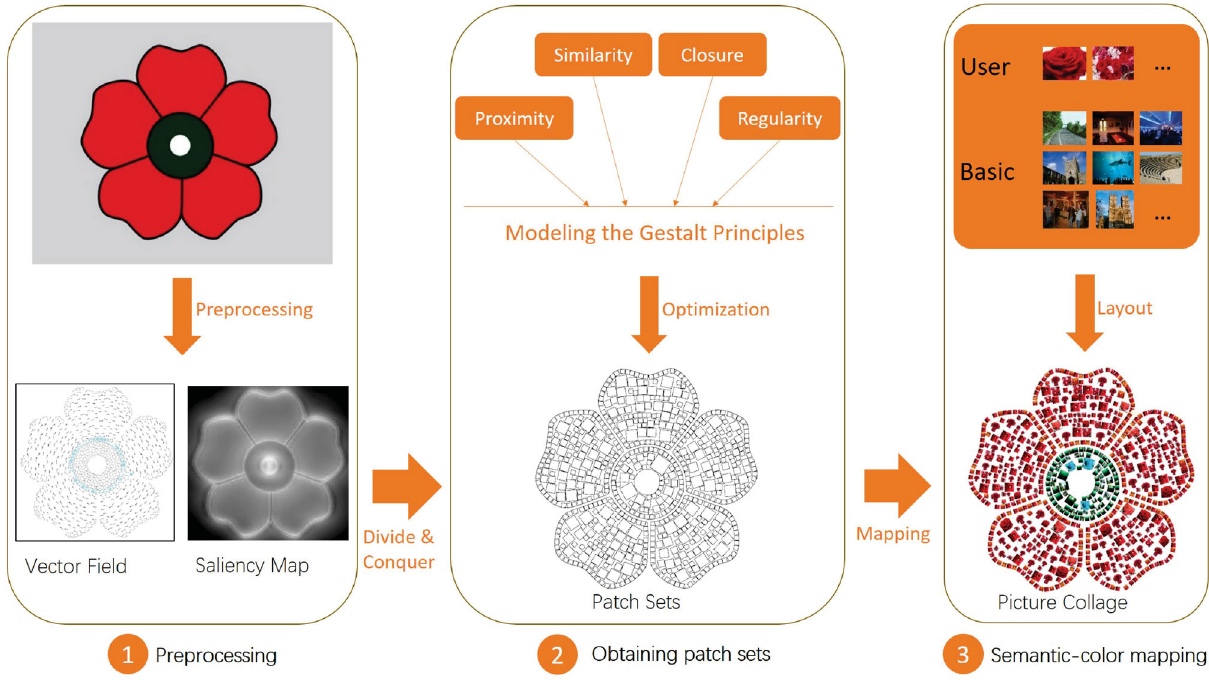
Fig. 2 Overview. Given a canvas image (1, above), we first generate a vector field and a saliency map (1, below). Next, we adopt a divide and conquer strategy to obtain a series of patch sets along the vector field; each patch’s size is controlled by the salience of its location. Then, based on Gestalt principles (2, above), we use an energy function to choose the best patch set (2, below). Finally, using a semantic-color similarity metric, we map the picture set to the patch set to generate the final collage (3,